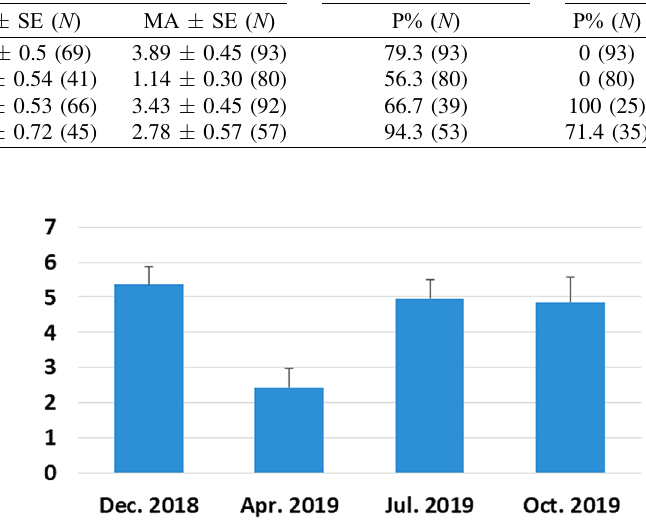
Figure 7. Mean intensity of infection of Coptodon guineensis at Sebkha Imlili by acanthocephalan Acanthogyrus ( Acanthosentis ) cf. tilapiae (December 2018: n = 69; April 2019: n = 41; July 2019: n = 66; October 2019: n = 45). Mean intensity was signi fi cantly lowest in